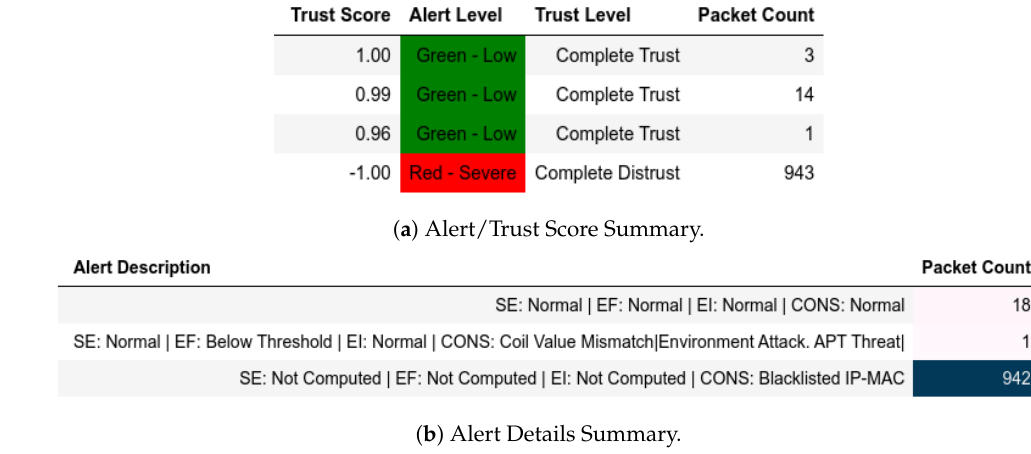
Figure 17. Server: EPM dataset internal test with IP-MAC blacklisting- H m in send-fake-command attack capture.